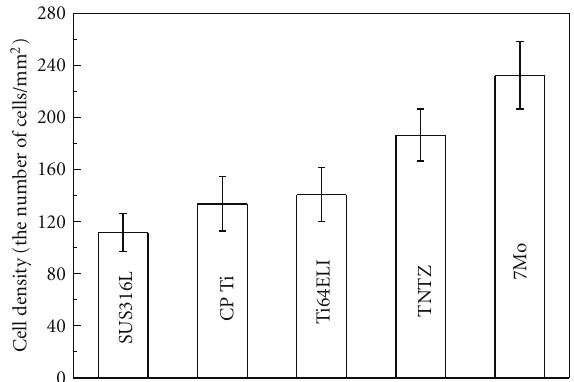
Figure 16: Density of cells cultured in 7Mo and the alloys considered for comparison for 24h.